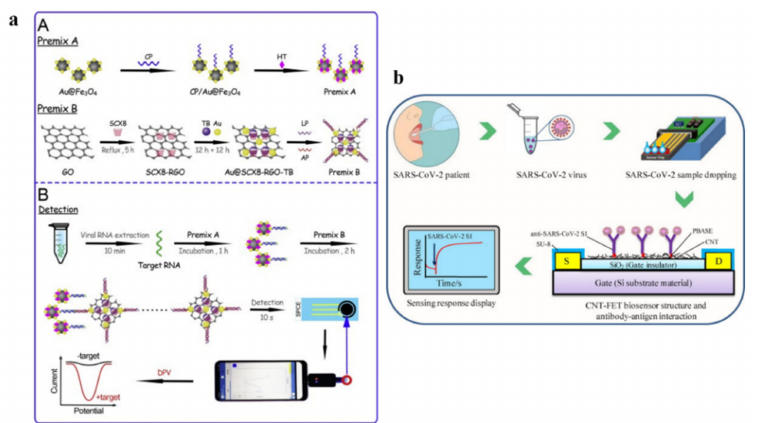
Figure 3. Schematic illustration of electrochemical biosensors fabricated with carbon nanomaterials for detection of SARS-CoV-2: ( a ) biosensor based on graphene oxide with calixarene functionality for detecting RNA of SARS-CoV-2 via a smartphone [64]; ( b ) biosensor based on CNT-FET for detecting SARS-CoV-2 S1 antigens [79]. Note: ( a , b ) are reproduced with permission Copyright 2021, Elsevier